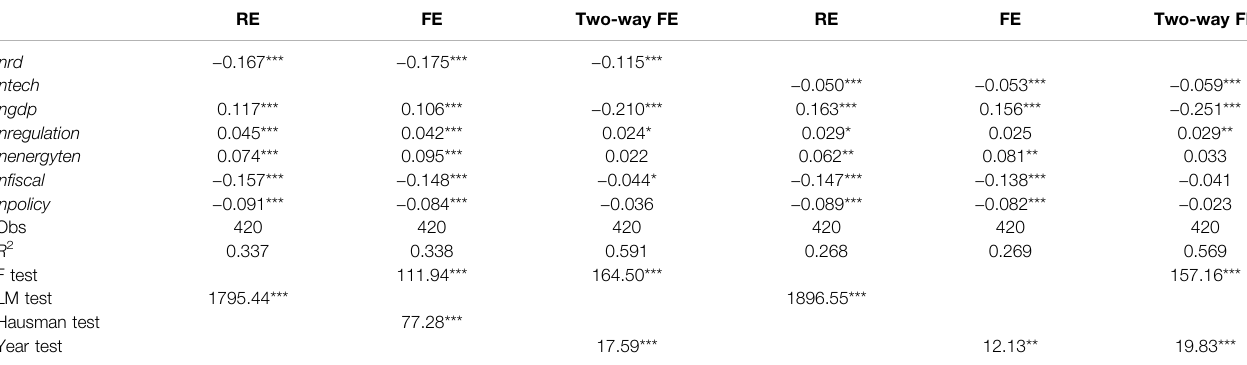
TABLE 3 | Robustness test results with lnrd and lntech .